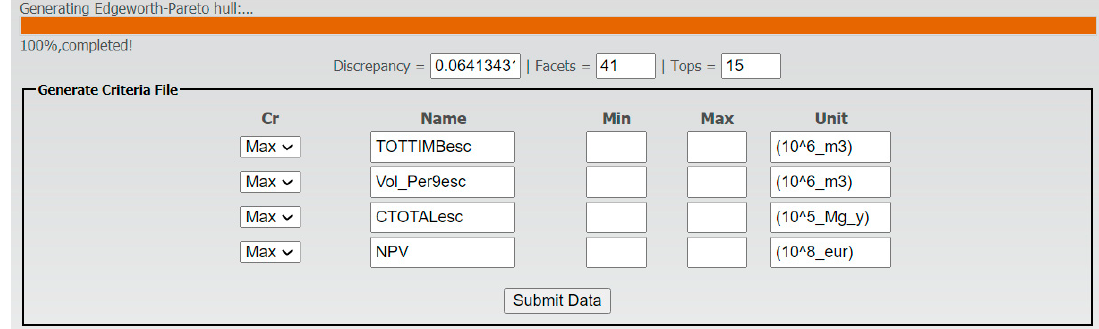
Figure 8. Wgui for choosing the criteria to be used in the construction of the Pareto hull.